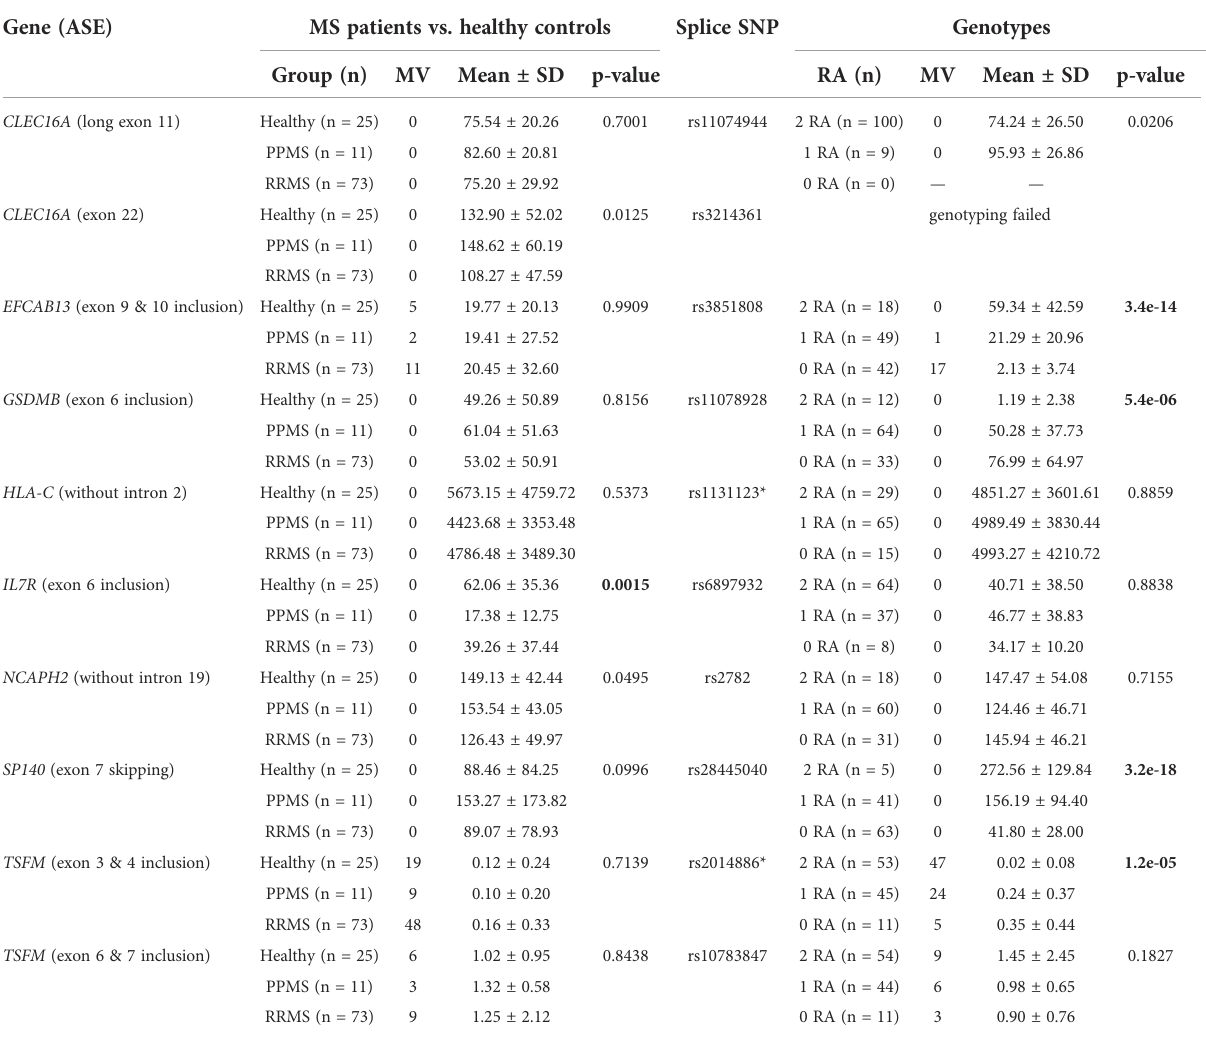
TABLE 5 Differential expression of transcript isoforms in the qPCR data set. Gene (ASE) MS patients vs. healthy